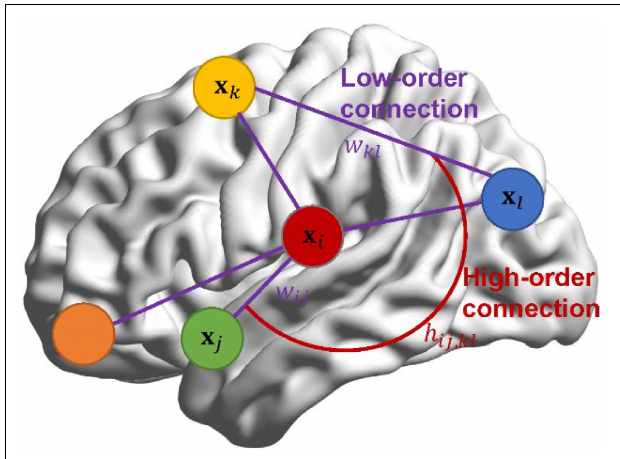
FIGURE 1 | The diagram of low- and high-order